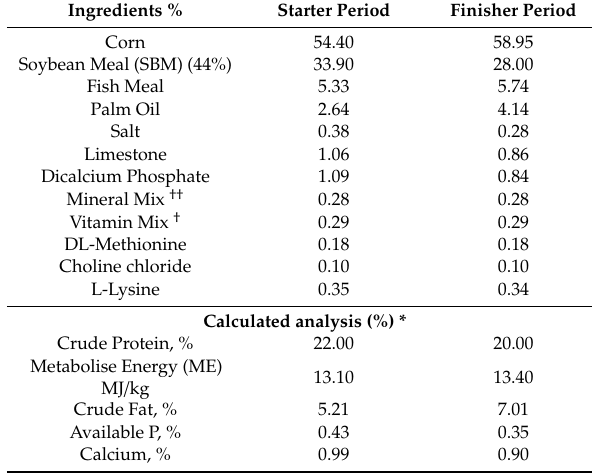
Table 1. Ingredients (% as feed) and nutritional analysis of the basal diet. Ingredients